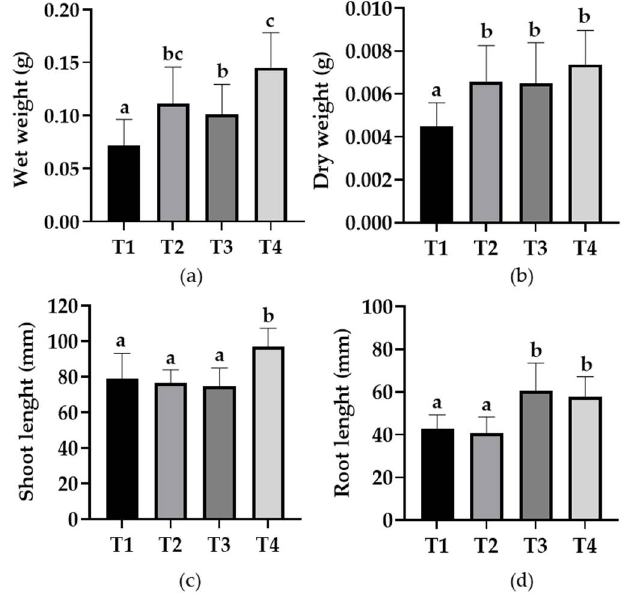
Figure 5. Evaluation of the growth of tomato seedlings from seeds inoculated with bacteria. The evaluation was performed 21 days after seed inoculation. ( a ) Wet weight assessment. ( b ) Dry weight assessment. ( c ) Shoot length assessment. ( d ) Root length assessment. Letters on the bars represent the comparison using an LSD test (α = 0.05) between treatments. Different letters in each figure represent statistically significant differences.